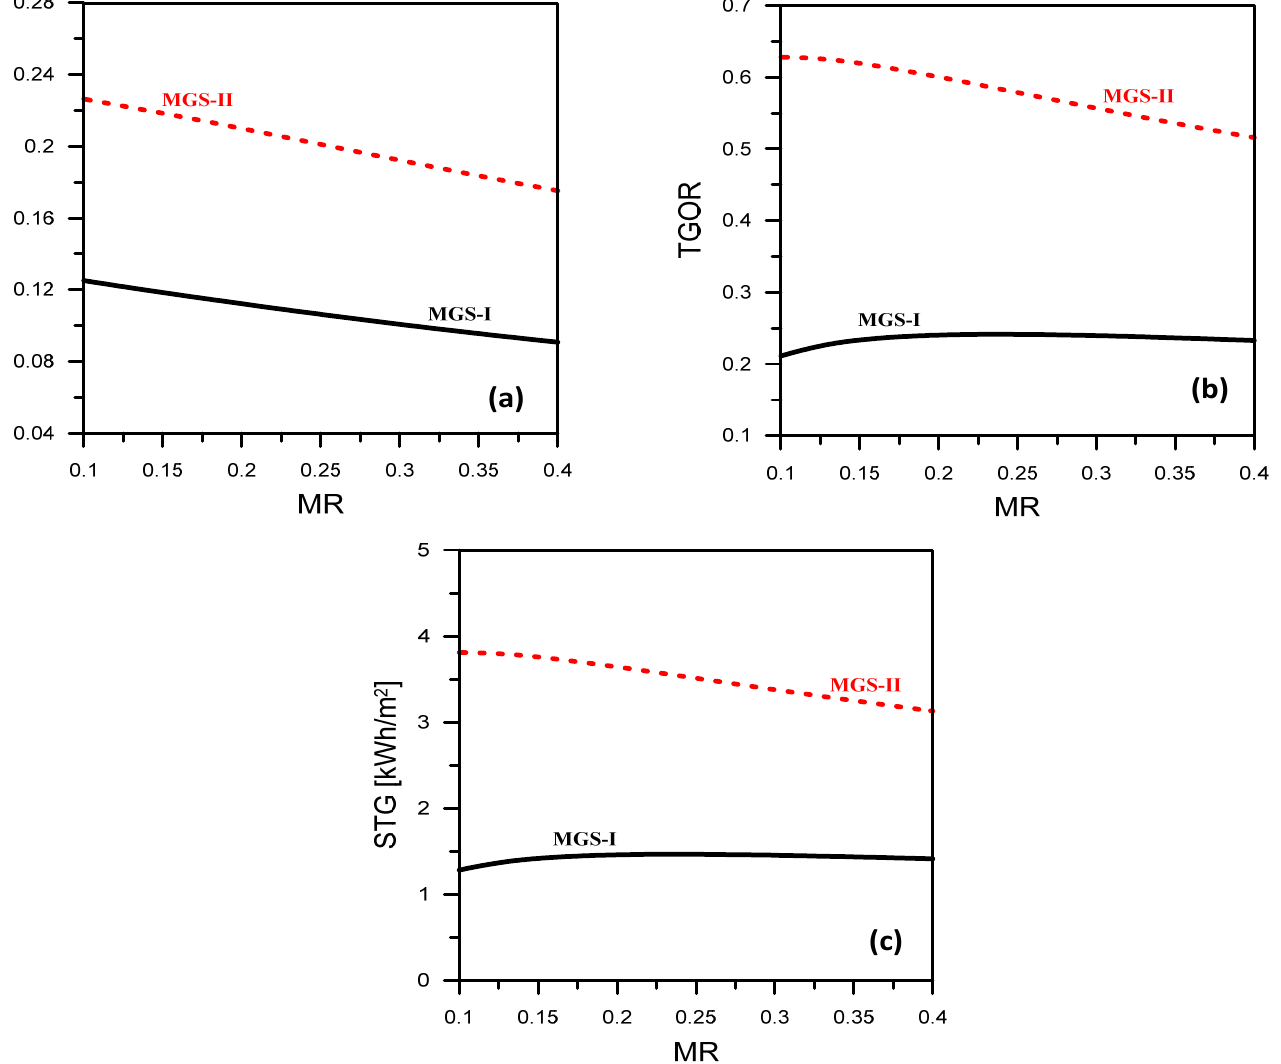
Figure 8. Impact of mass flow rate ratio on proposed systems’ performance: ( a ) GOR HDH ; ( b ) TGOR; ( c ) STG.